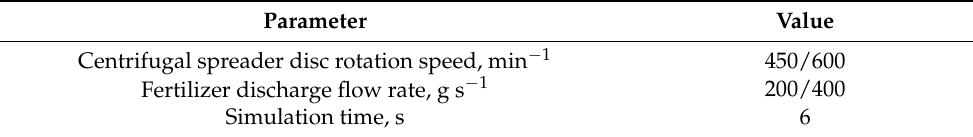
Figure 3. Spinning discs: ( a ) real ones; ( b ) their model developed in EDEM software. The solid works flow software was used to create the dual disc fertilizer spreader model. The model was saved in the Initial Graphics Specification format (.igs) and imported into the EDEM (v4.0.0) software. The parameters of the fertilizer spreader selected for modeling in the EDEM software are presented in Table 3. Table 3. Parameters of fertilizer spreader selected for modeling.